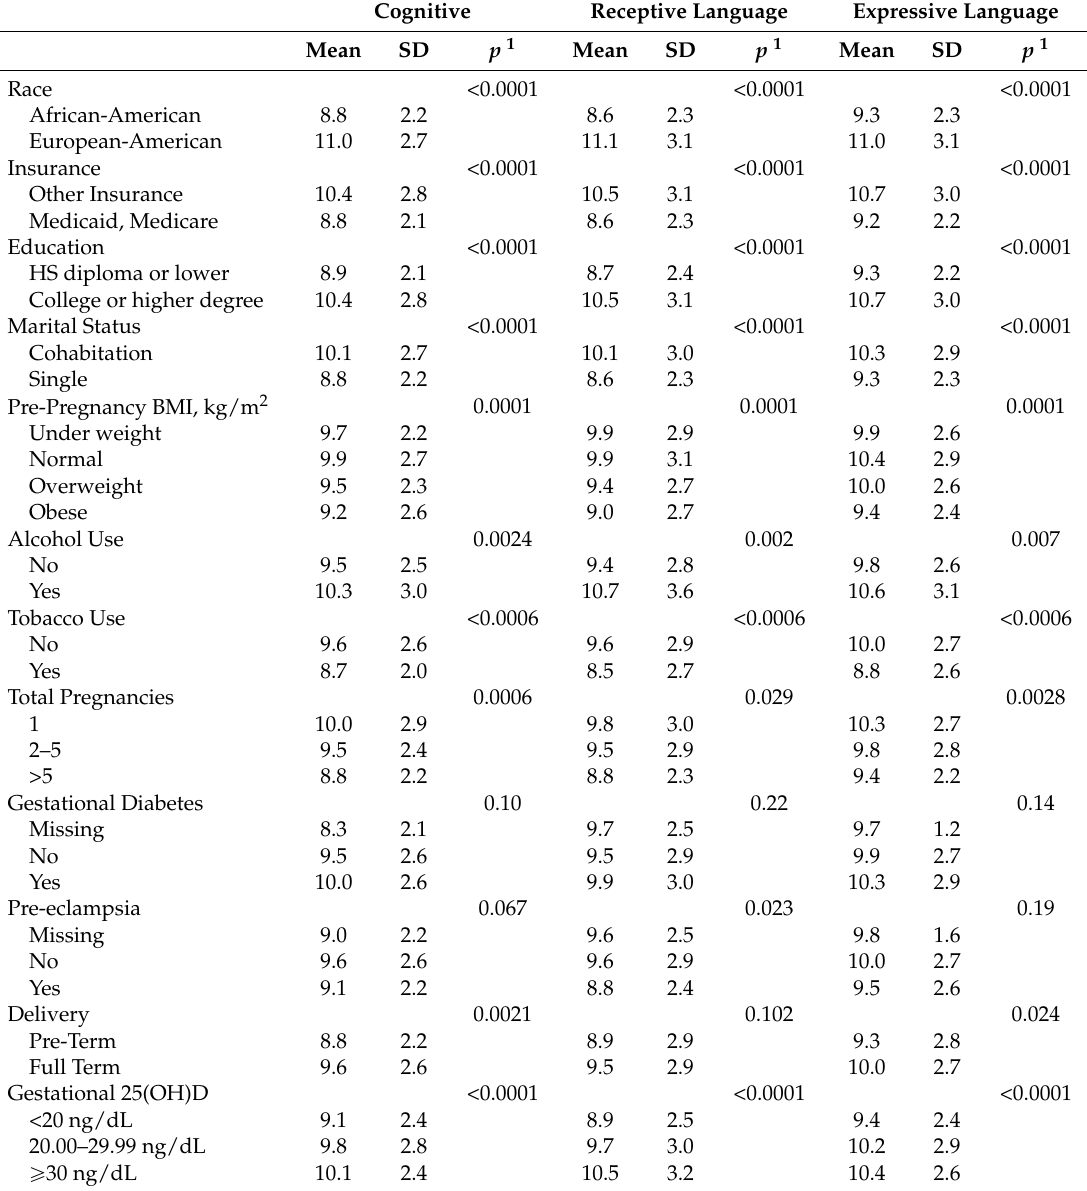
Table 2. Scaled Developmental Scores by Selective Characteristics ( n =